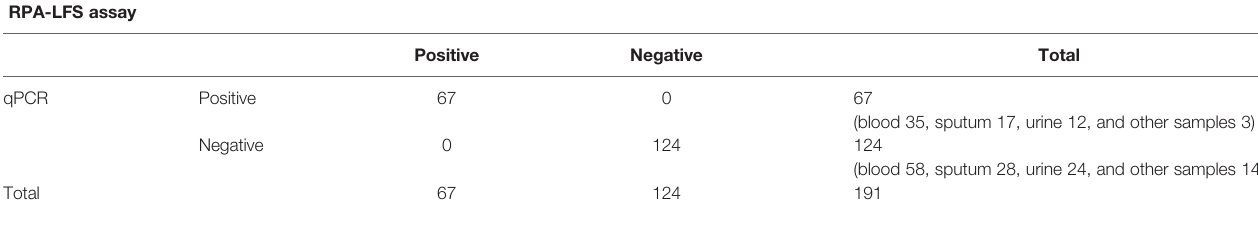
TABLE 3 | Prevalence of ITS2 gene in 191 clinical samples of C . tropicalis using RPA-LFS and qPCR (summarized). RPA-LFS assay